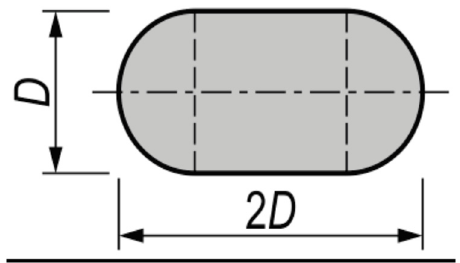
Figure 11. Shape and dimensions of SPH bird model.